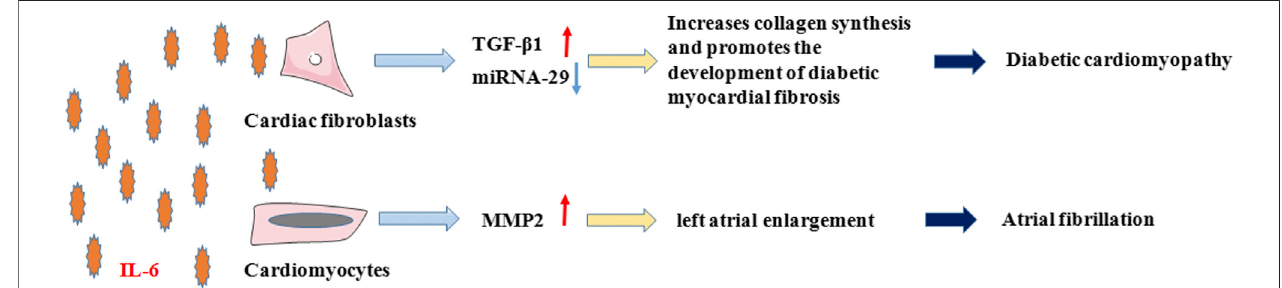
FIGURE3| IL-6inDiabeticcardiomyopathyandAtrial fi brillation.Indiabeticcardiomyopathyandatrial fi brillation,ontheonehand,IL-6promotesthedevelopment of diabetic myocardial fi brosis by enhancing TGF- β 1 and inhibiting the expression of miRNA-29 in cardiac fi broblasts, which increases collagen synthesis. On the other hand, IL-6 promotes the secretion of MMP-2 from cardiomyocytes, which causes atrial fi brillation due to enlargement and remodeling of the left atrium.